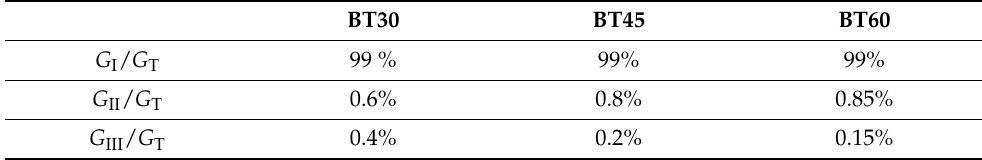
Table 5. Mix-modes Table 5. Mix-modes contributions.